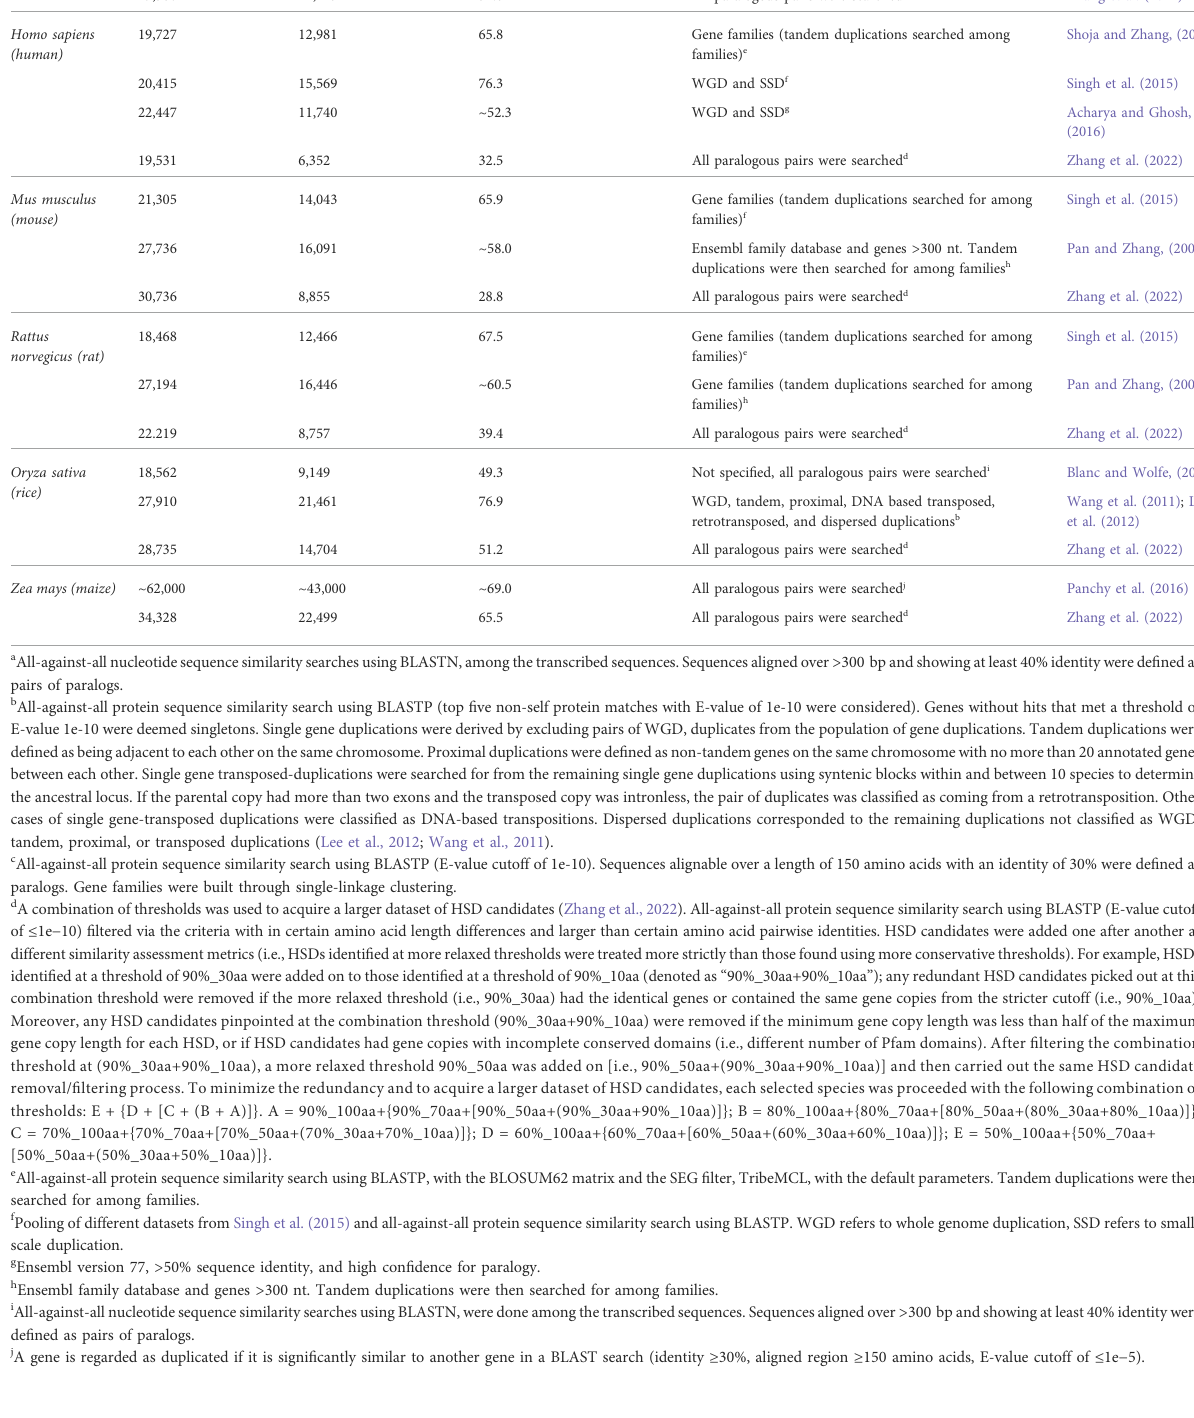
TABLE 1 Estimation of the amount of duplicated genes in different species. Adapted from (Lallemand et al., 2020) under the creative commons attribution license. Species No. of median gene count